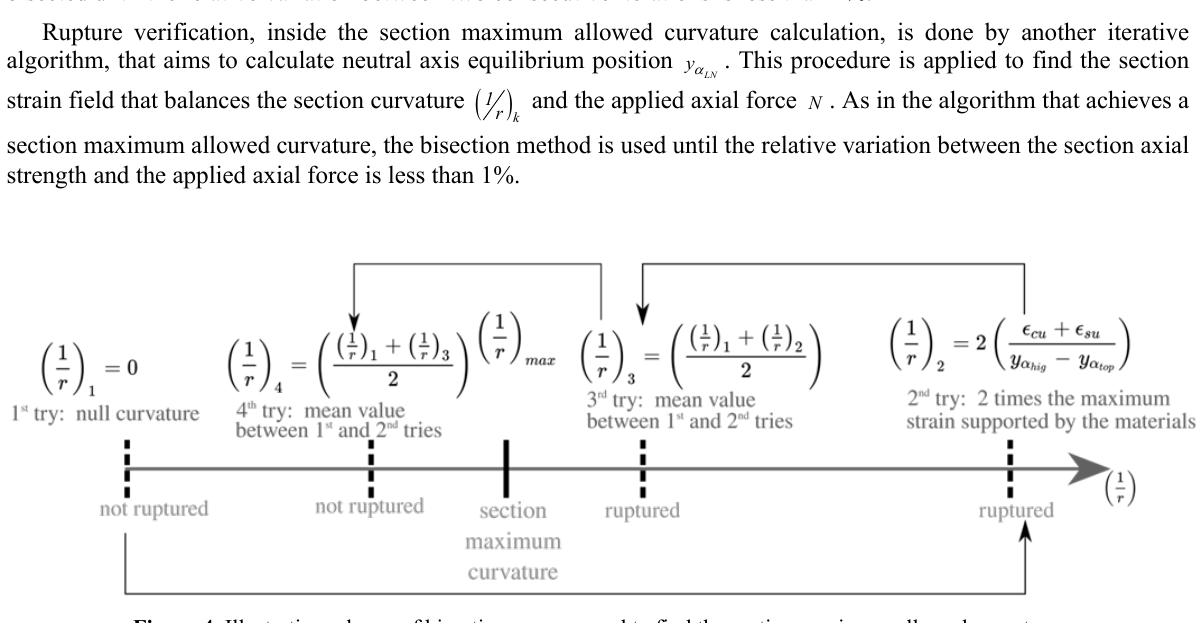
Figure 4. Illustrative scheme of bisection process used to find the section maximum allowed